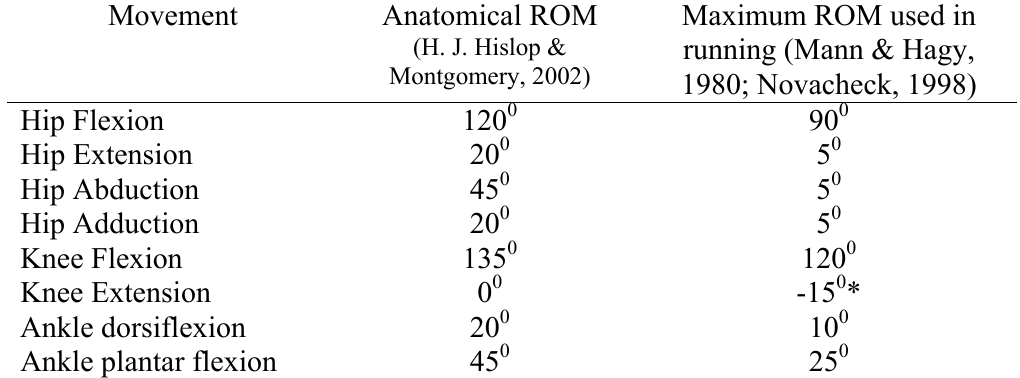
Table 3 : Comparison of normal anatomical range of movement (ROM) and the maximum ROM required for